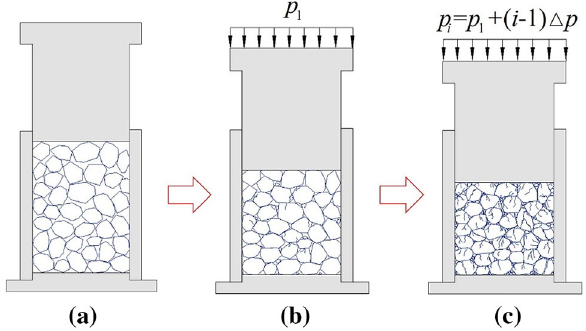
Fig. 11 The compaction and creep process of crushed mudstones under step